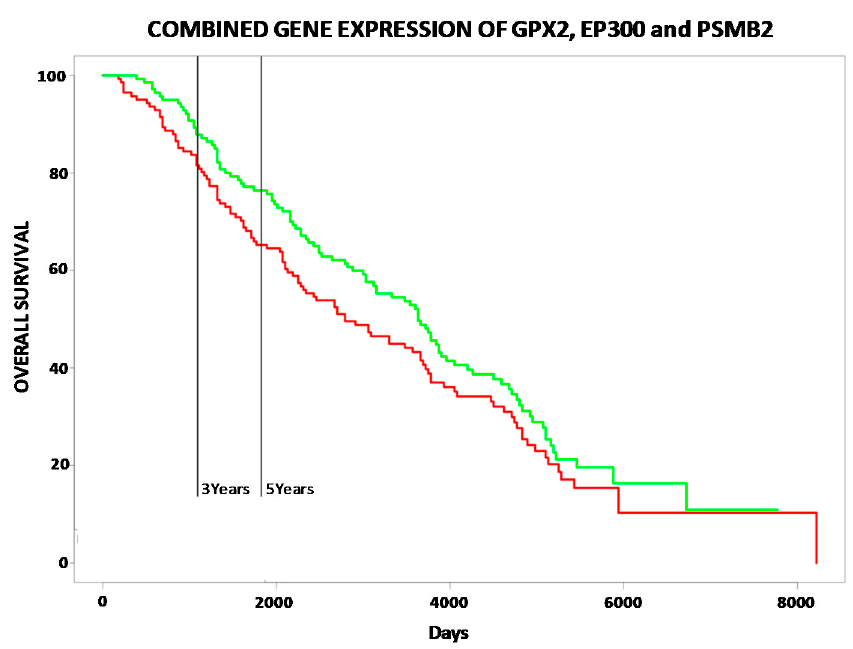
Figure 6. Kaplan-Mayer curves showing the correlations between overall survival (expressed in percentage) and the combined gene expression of GPX2, EP300, and PSMB2 in prostate cancer patients, which was based on the PROGgeneV2 online tool. High and low expression of selenoproteins are reported by the red and green curves, respectively.